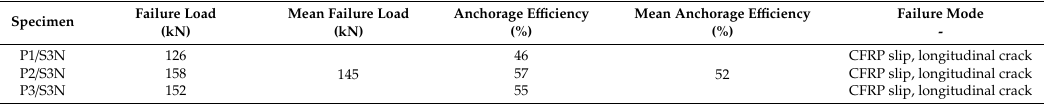
Table 6. Test results of the specimens tested in S3N series.